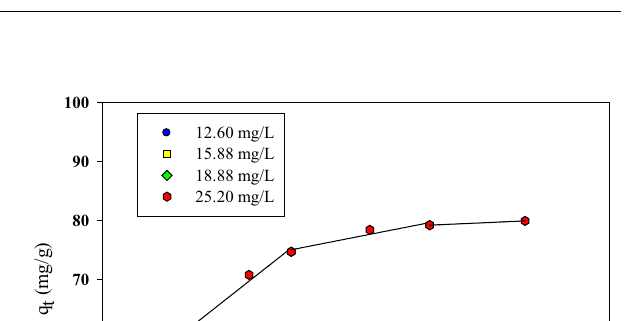
Table 2 Compute data from Fig. 3b for q e and k 2 of pseudo second-order kinetics for adsorption of methylene blue on coconut coir dust at 30 °C